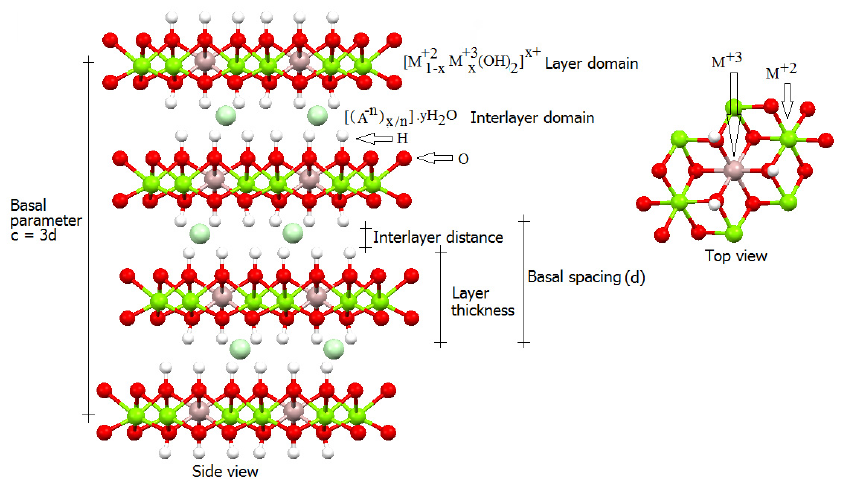
Figure 2. Schematic representation of a generic 3R Layered Double Hydroxide (LDH) structure [36,37].